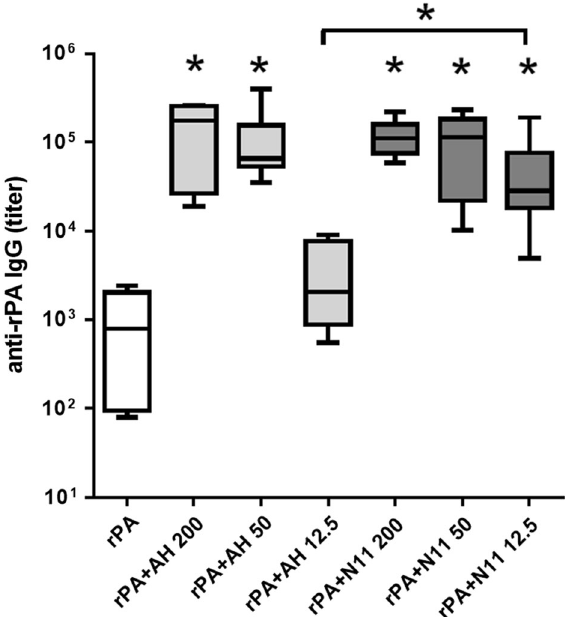
Fig. 1 Nano-11 has comparable adjuvanticity as aluminum hydro- xide adjuvant (AH) and shows superior immunopotentiation at low dose. Mice were immunized twice with 2 μ g of recombinant protective antigen (rPA) from Bacillus anthracis alone or adjuvanted with either AH or Nano-11 at three different dosages (200, 50, and 12.5 μ g). Titers of rPA-speci fi c IgG in the serum were measured through ELISA. Mean ± SEM of six mice. * p <